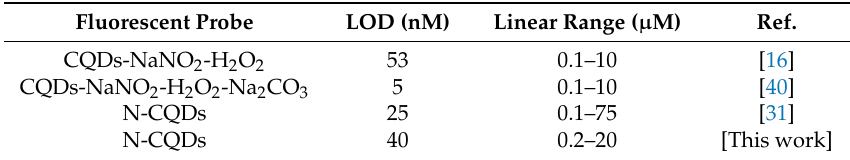
Figure 6. Fluorescence spectra of N-CQDs in the presence of different NO 2 − concentrations (from top to bottom : 0, 0.2, 0.4, 0.6, 0.8, 1, 2, 3, 4, 5, 6 and 20 µ M) in deionized water. The inset shows the dependence of F 0 /F on the concentrations of NO 2 − within the range of 0–20 µ M. Table 1. Comparison of LOD and linear range for NO 2 − different CQDs fluorescent probes.